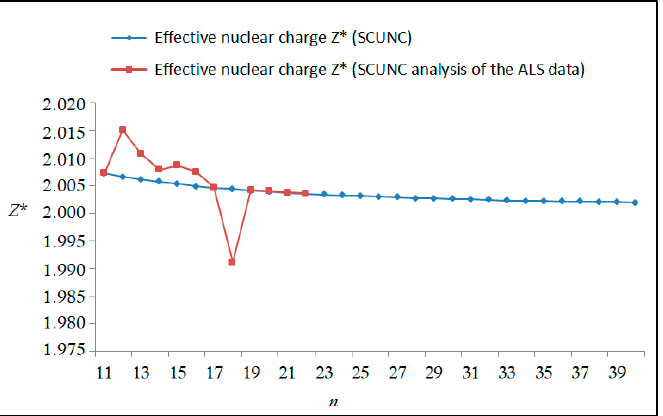
Figure 4. Variations of the effective nuclear charge Z* with the principal quantum number n for the Atoms 2022 , 10 , 107 11 of 26 4 s 2 4 p 2 ( 3 P 2 ) nd Rydberg series originating from the 2 P ◦ 3/2 metastable state of Se + converging to the 3 P 2+ . 2 series limits in Se